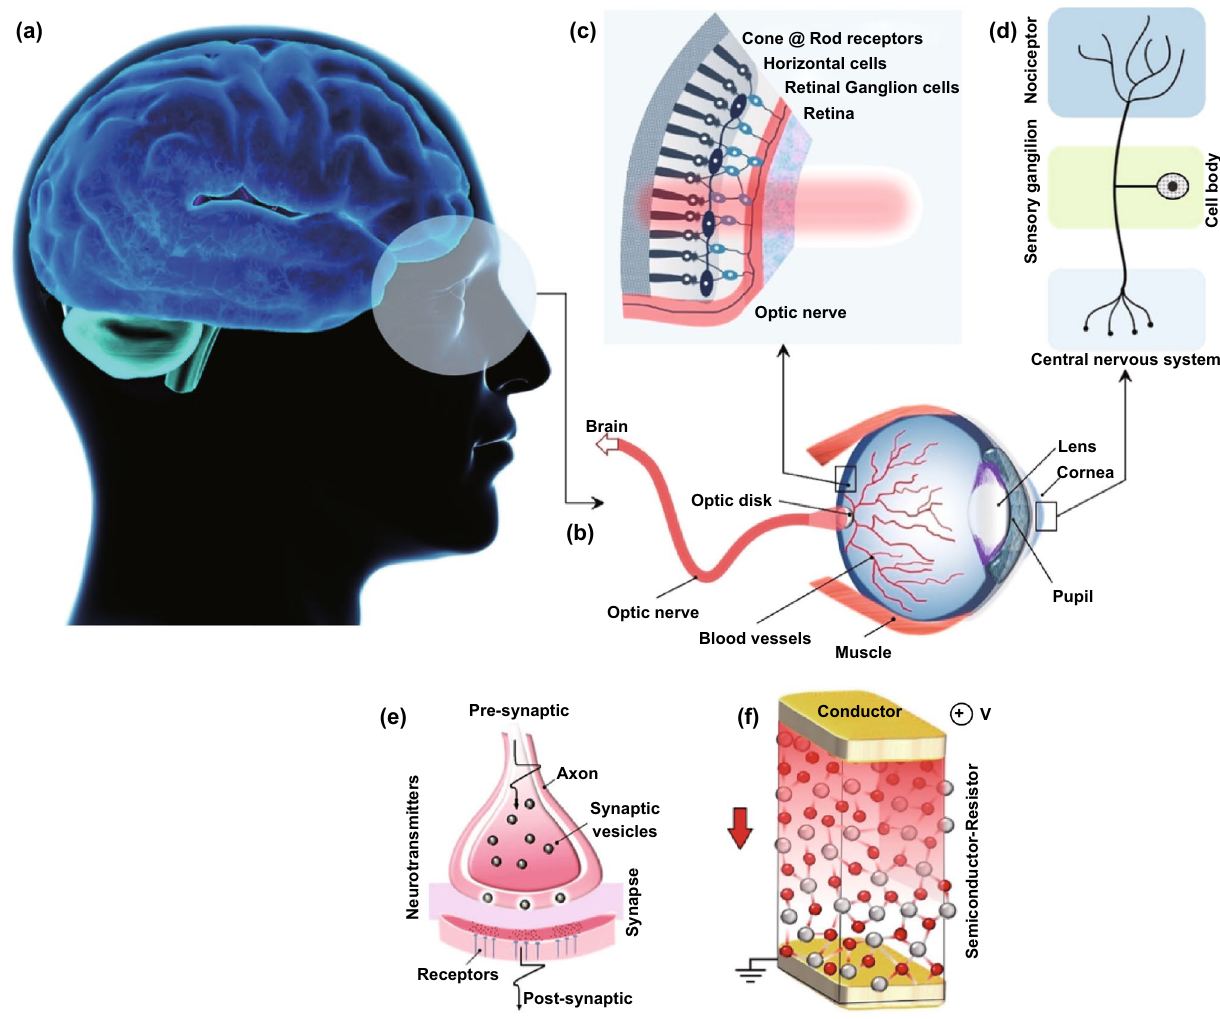
Fig. 1 The scheme of human eye receptor and nociceptor system. a Human brain as decision making unit receives the informative signals from b human eye and its sensory components including the c light receptors and nociceptors in retina section. d Typical nociceptor with its compo- nents. e Typical schematic representation of a natural synapse and f its artificial counterparts in conductor/semiconductor/conductor-sandwiched